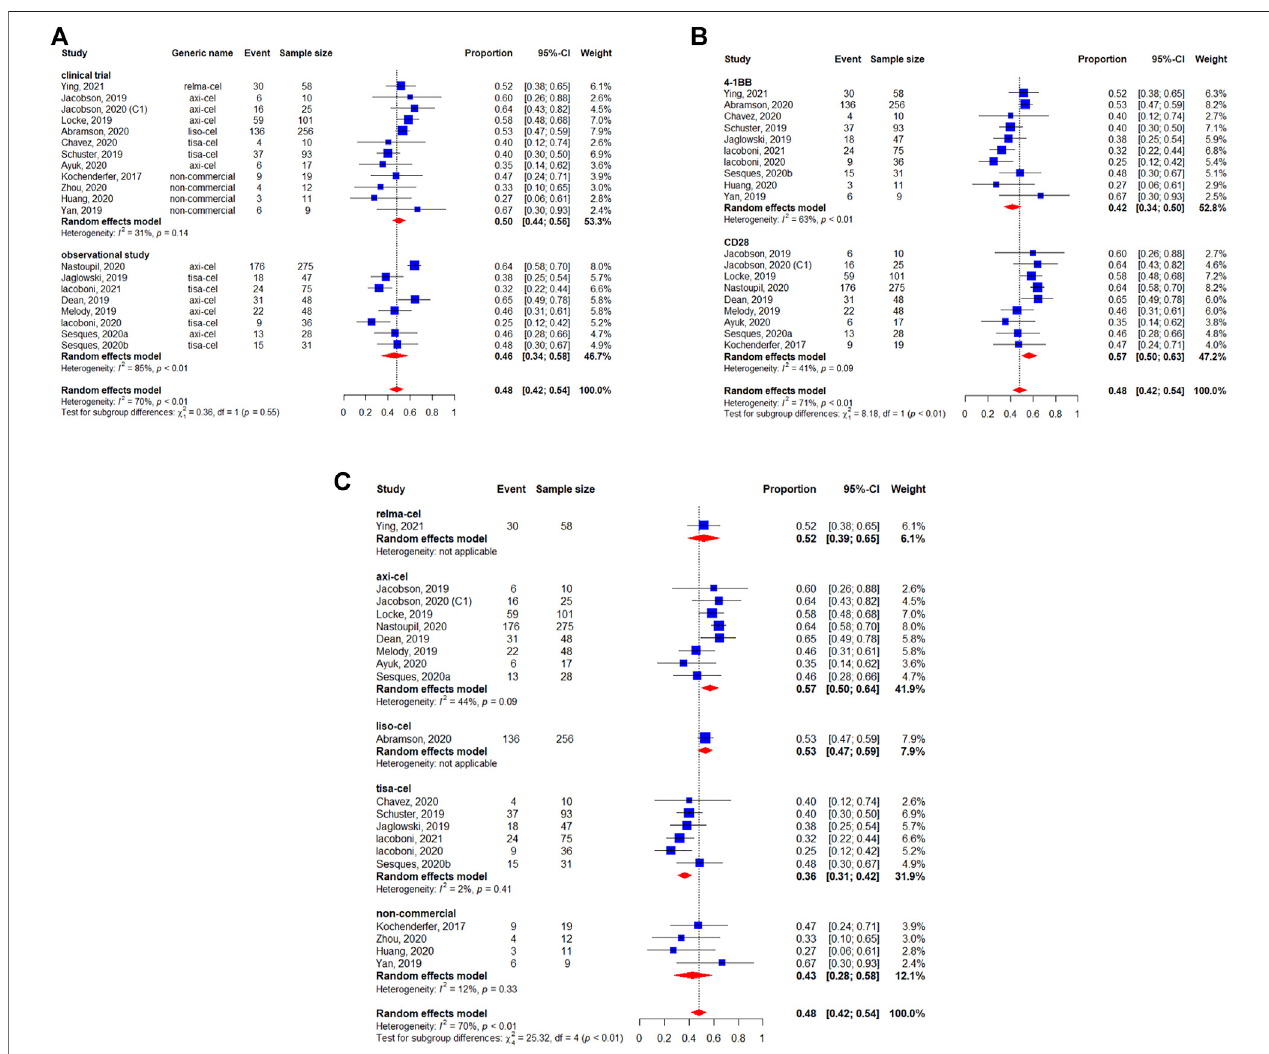
FIGURE 3 | Subgroup analyses of best complete response (BCR) rate of patients with diffuse large B-cell lymphoma (DLBCL) treated with chimeric antigen receptor T cells (CAR-Ts) according to (A) study design, (B) the costimulatory domain, and (C) type of chimeric antigen receptor T cells (CAR-T).